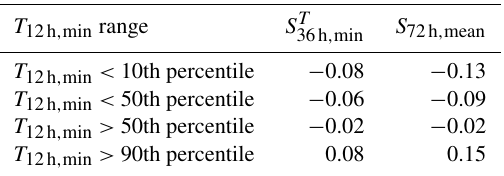
Table 3. τ estimate between S T S 72h , mean and P 12d , acum , as a function of T 12h , min